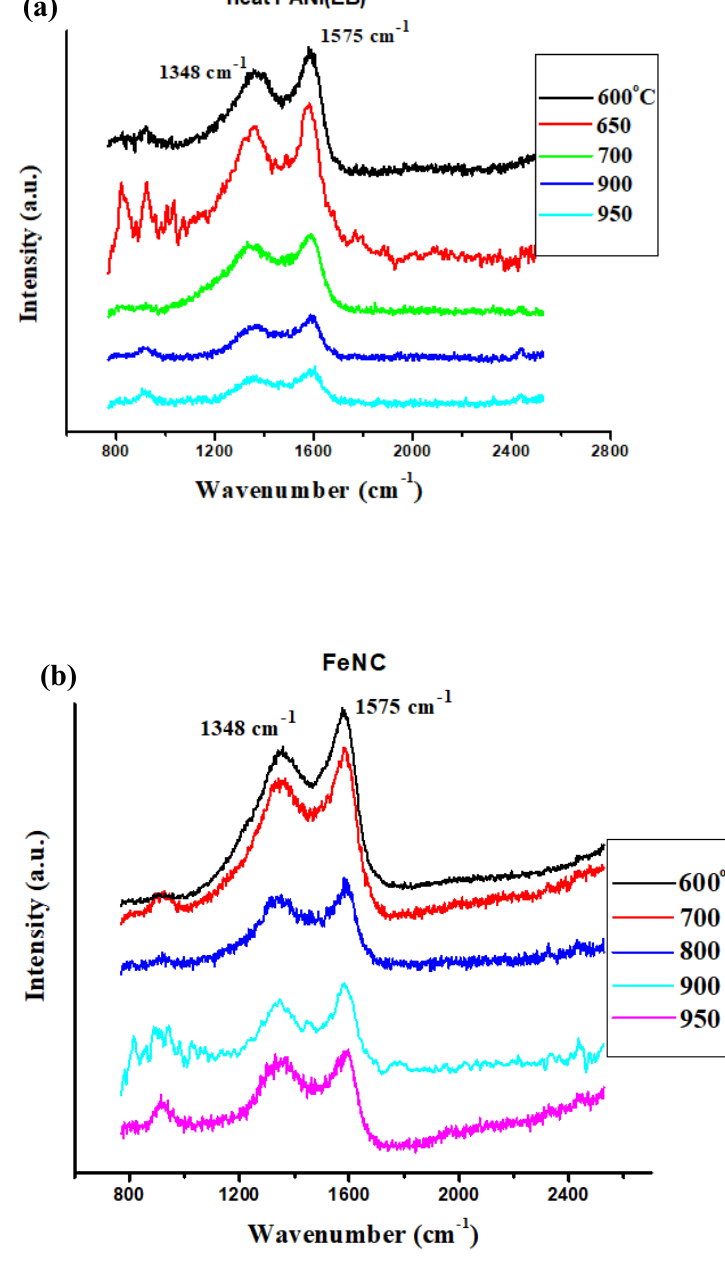
Figure 7. Raman - spectra of ( a ) neat PANI(EB) ( b ) FeNCs. Figure 7. Raman-spectra of ( a ) neat PANI(EB) ( b )